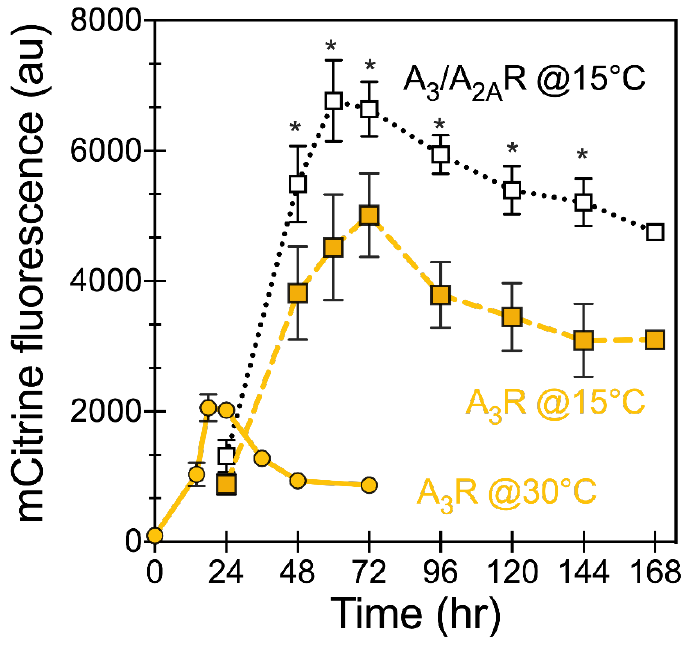
Figure 4. Improving receptor expression by growth at higher initial cell density (5 OD 600 /mL) and induction temperature of 15 ◦ C. Whole cell mCitrine fluorescence was monitored by cells growing in defined media (SG-ura). Yellow-filled circles (30 ◦ C) and squares (15 ◦ C) denote A 3 R, whereas black open squares are A 3 / A 2A R at 15 ◦ C. Data points represent the average of at least 5 biological replicates; lines are a guide for the eye. Error bars represent the standard error of the mean value. Data points significantly di ff erent from A 3 R at 15 ◦ C are indicated with * ( p -value < 0.05 using Student’s t -test).